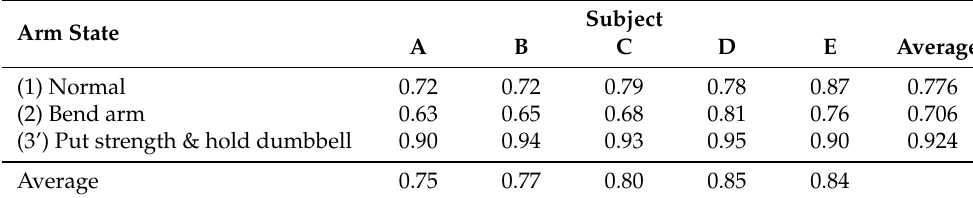
Table 1. F-value of muscle activity recognition.